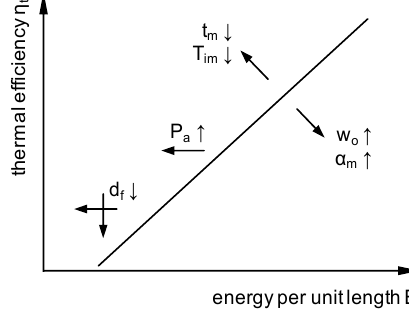
Figure 10. Qualitative illustration of the influencing parameters on thermal efficiency.